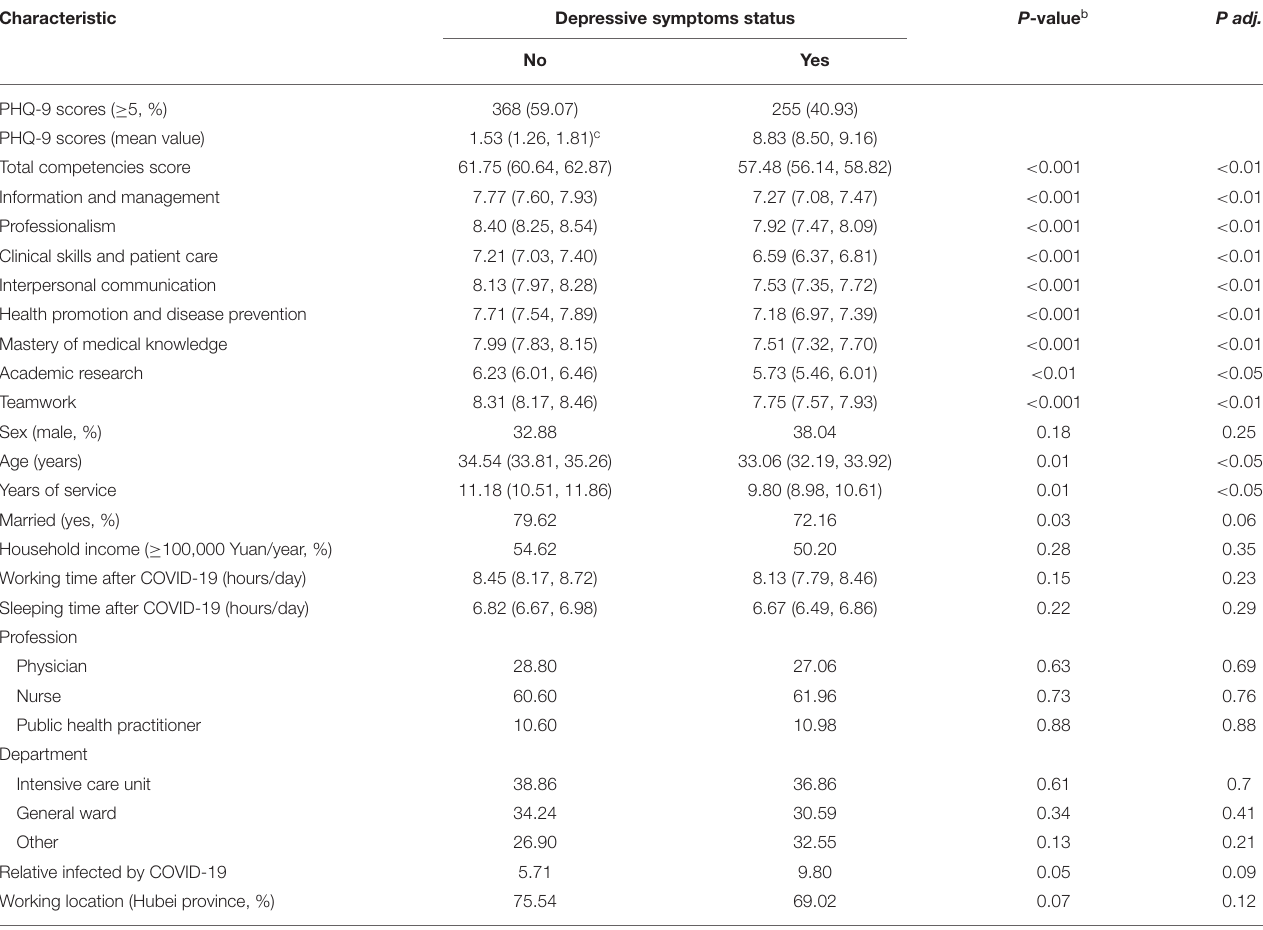
TABLE 1 | Participant characteristics, stratified by the presence of depressive symptoms a . Characteristic Depressive symptoms